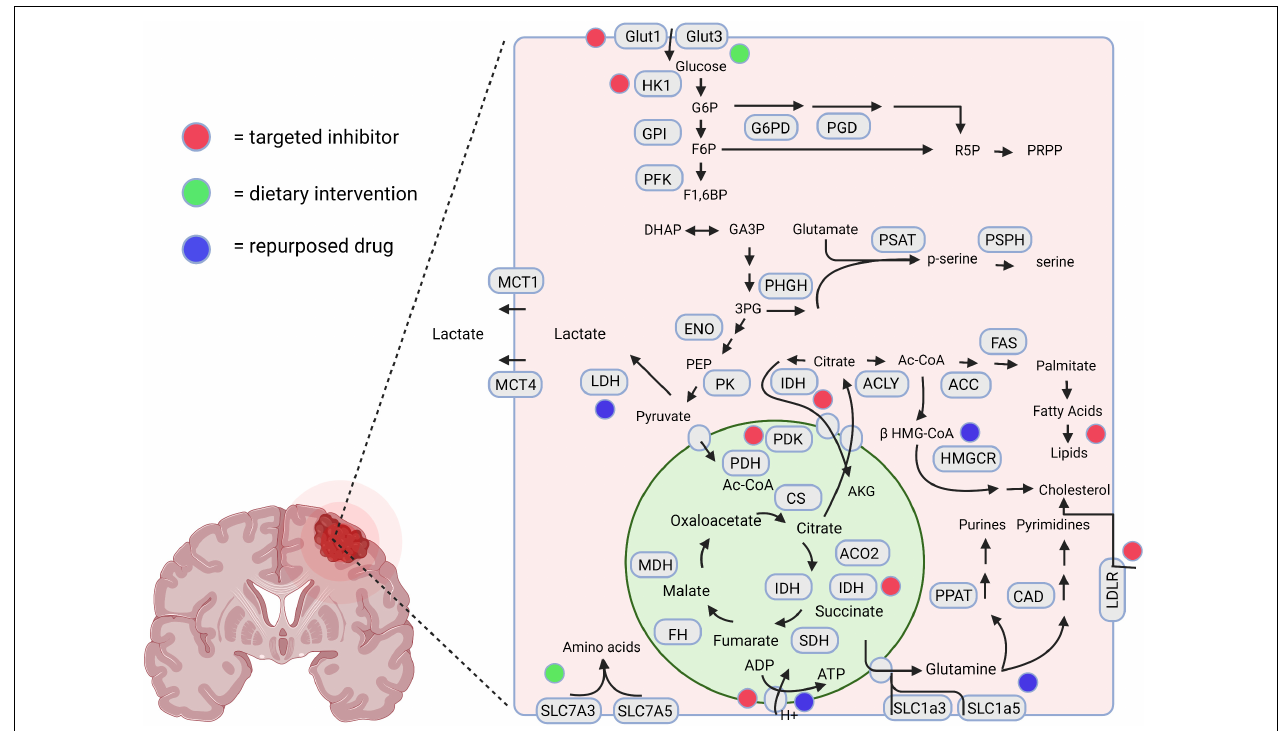
FIGURE 2 | A schematic representation highlighting the therapeutic interventions associated with GBM metabolism. The red, green, and blue dots depict the interventions using novel targeted inhibitors, dietary interventions, and repurposed drugs, respectively. Created using Biorender.com.